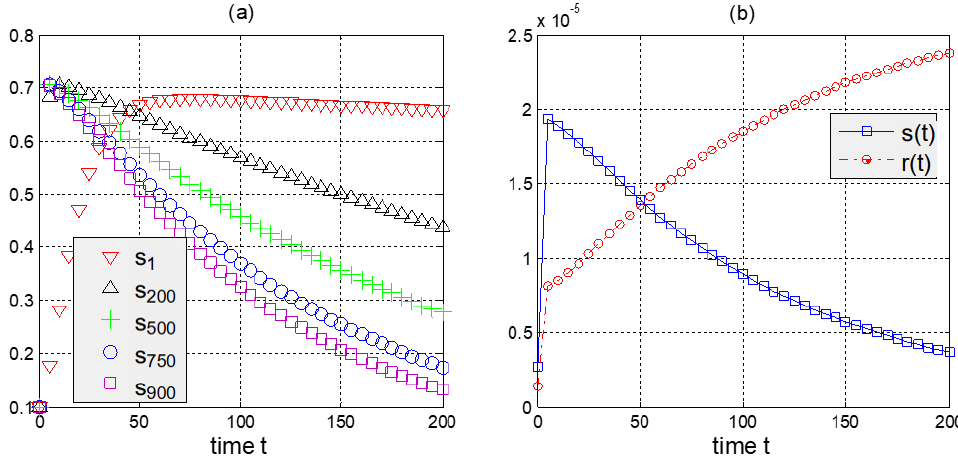
> 𝟏 , respectively; ( b ) The 𝟎 > 𝟏 𝟎